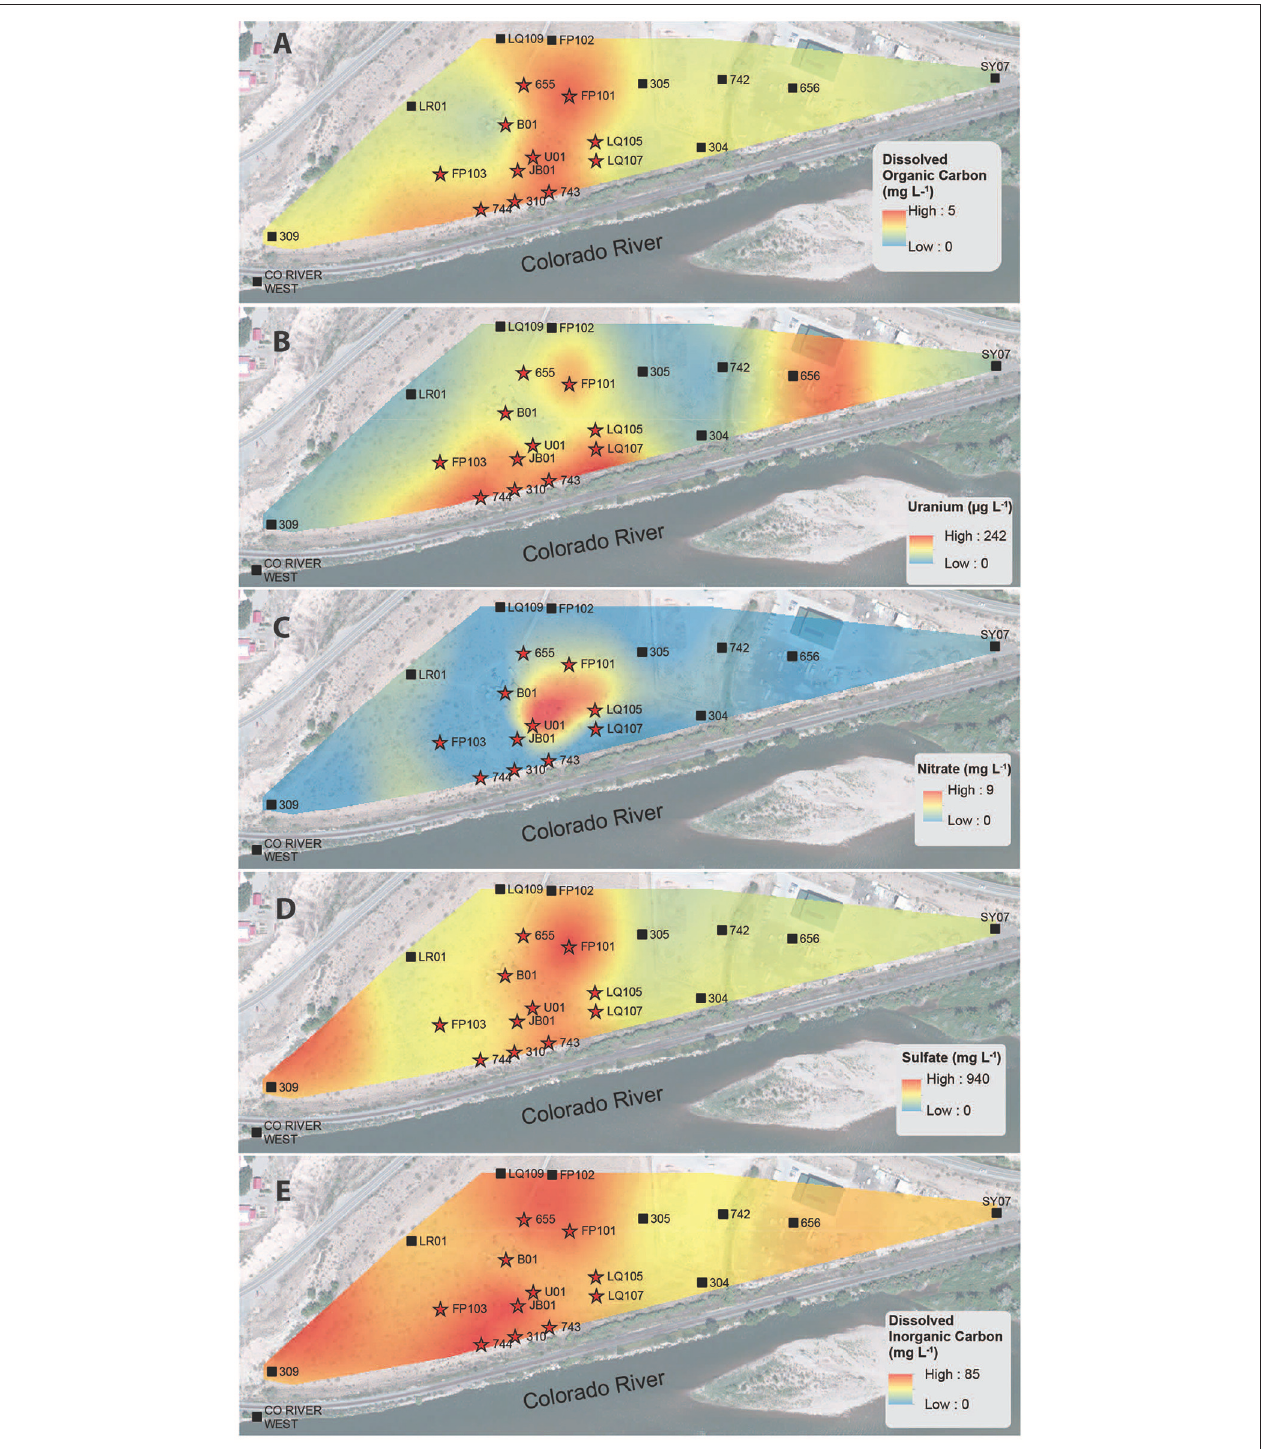
FIGURE 3 | Spatial interpolation of groundwater DOC (A) , uranium (B) , nitrate (C) , sulfate (D), and DIC (E) data collected from monitoring wells in the alluvial aquifer depicting spatial distribution. Color gradient from high (red) to low (blue) denotes interpolated concentrations.